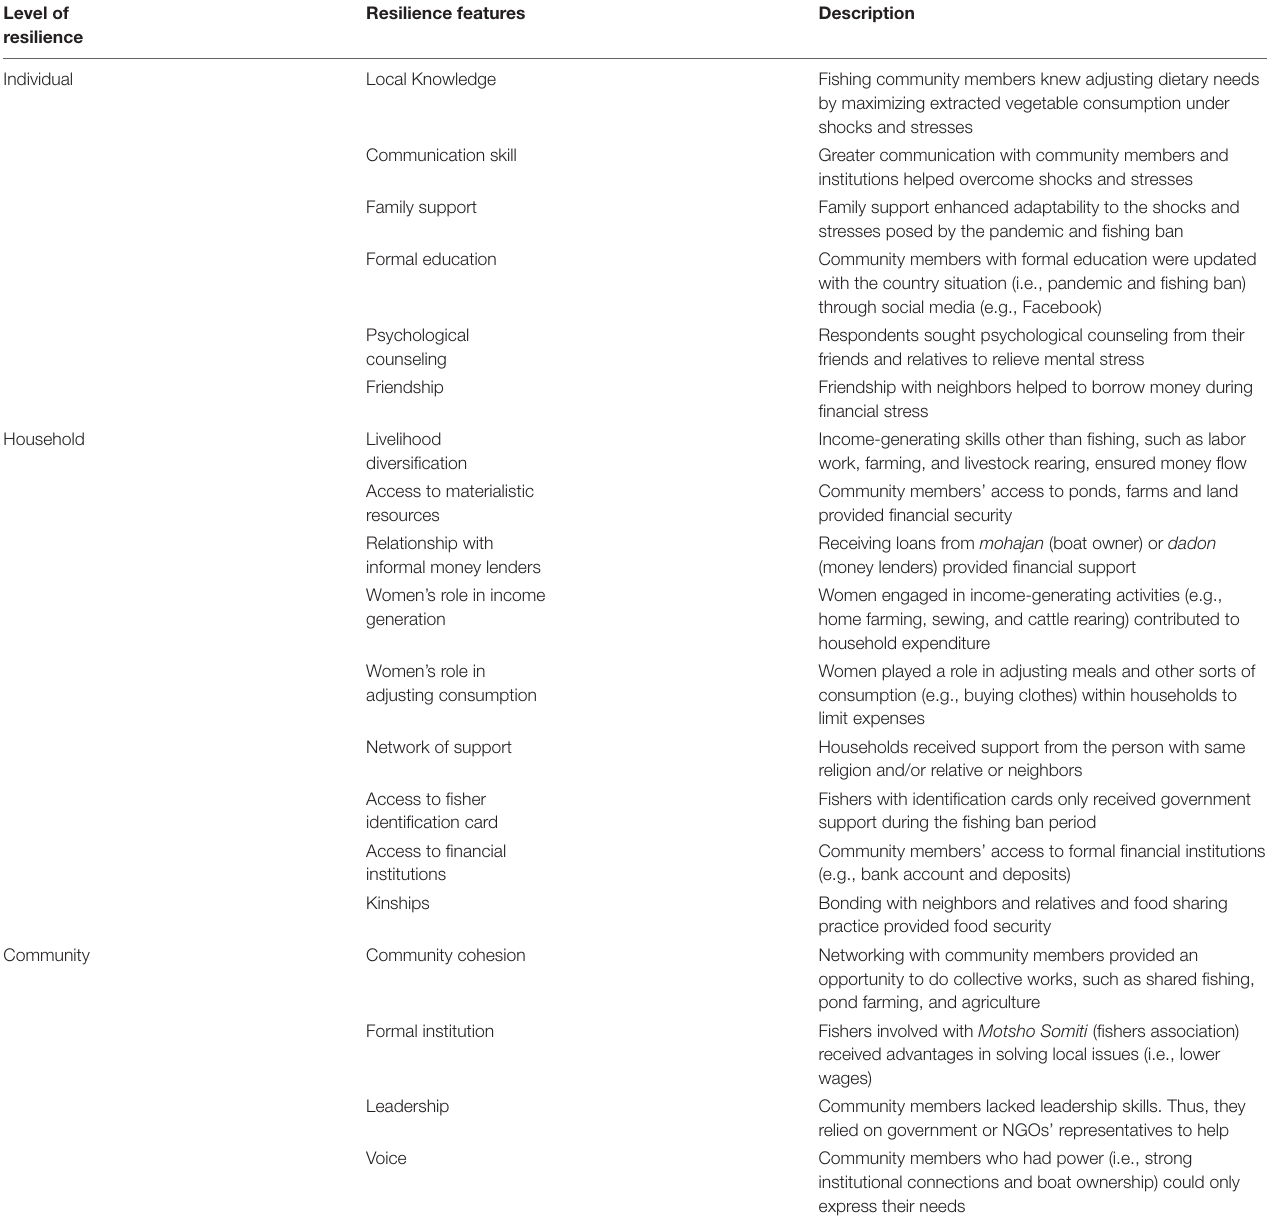
TABLE 2 | Multilevel resilience features as revealed by the study on fishing communities in